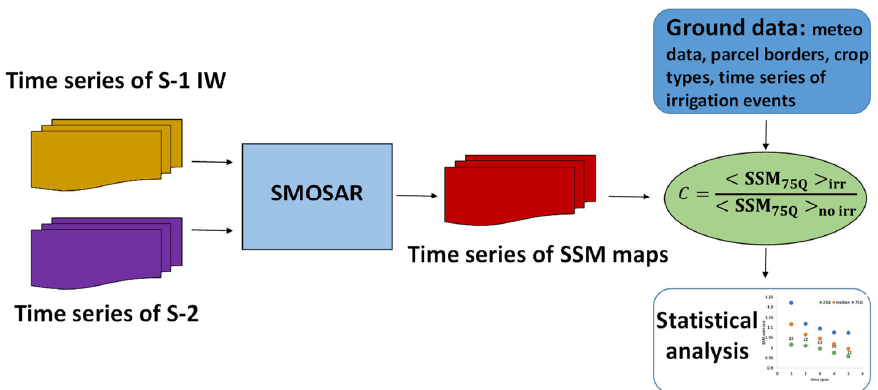
Figure 7. Data flow